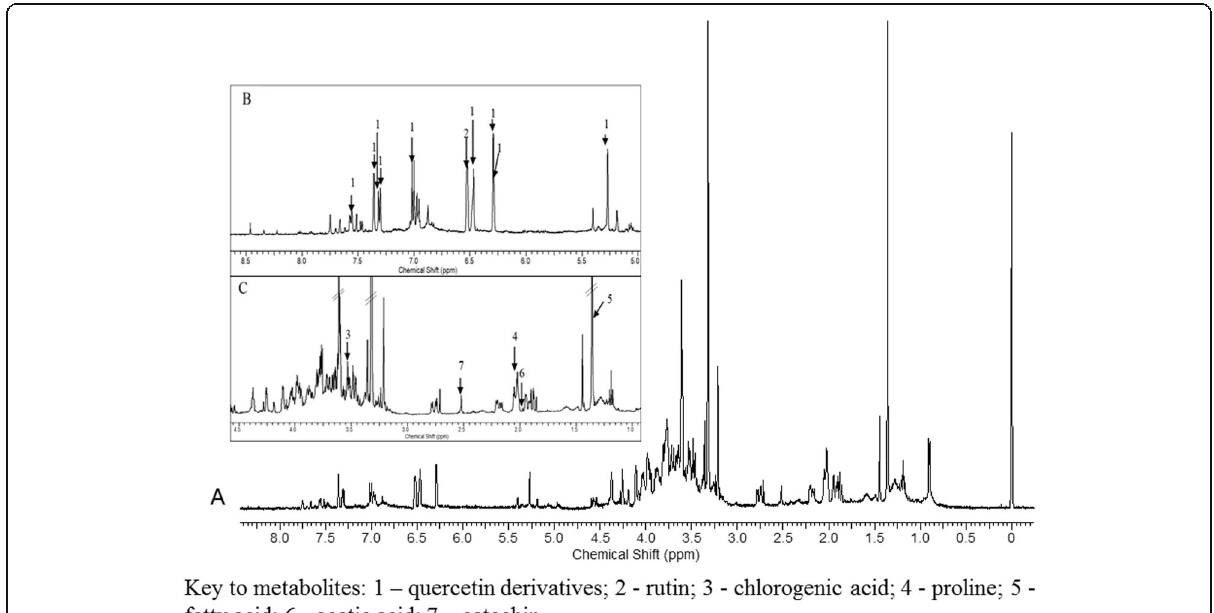
Fig. 1 a Full 1 H NMR spectrum of the EtOH:water (80:20) C. caudatus extract. b Expanded 1 H NMR spectrum in the range of δ 5.0 to 8.5. c Expanded 1 H NMR spectrum in the range of δ 1.0 to 4.5. Key to metabolites: 1 – quercetin derivatives; 2 - rutin; 3 - chlorogenic acid; 4 - proline;